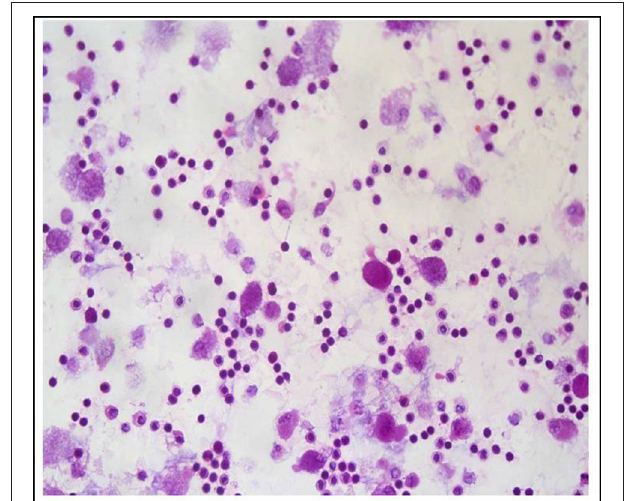
FIGURE 1 | High-resolution computed tomography scan in patients with non-fibrotic HP: (A) show inspiratory phase with diffuse centrilobular nodules, (B) expiratory phase in the same patient with centrilobular nodules and air trapping in right side; (C) in inspiratory phase present subpleural reticular pattern, with mosaic attenuation which is highlighted in the expiratory phase (D) .